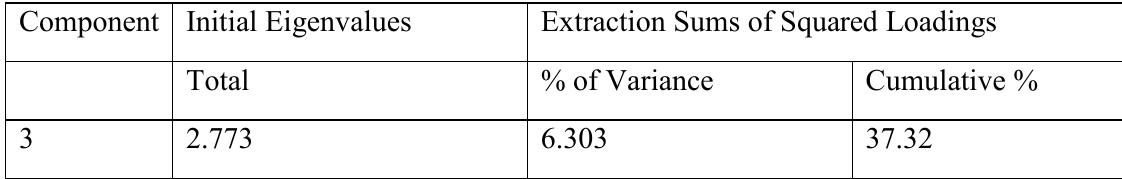
Table 1.5: Variance explained for Absorptive Resilience PC3